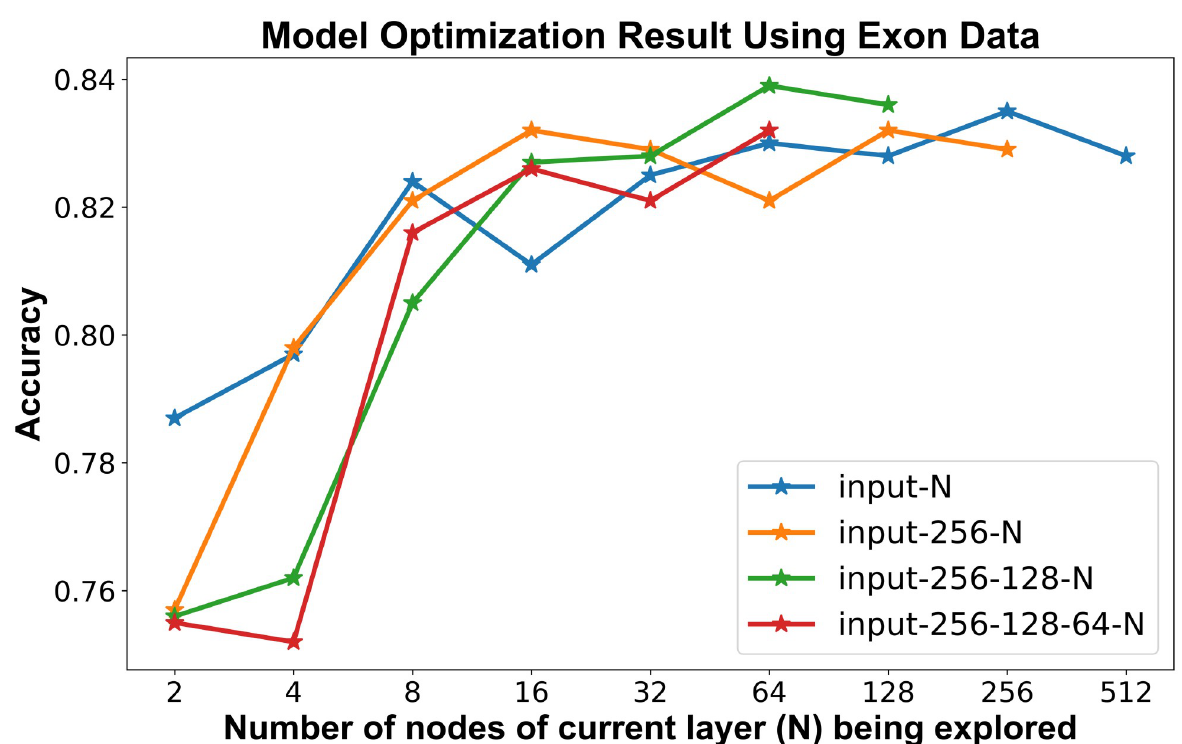
Fig 3. Cross-validation accuracy calculated during model optimization for exon-level data.